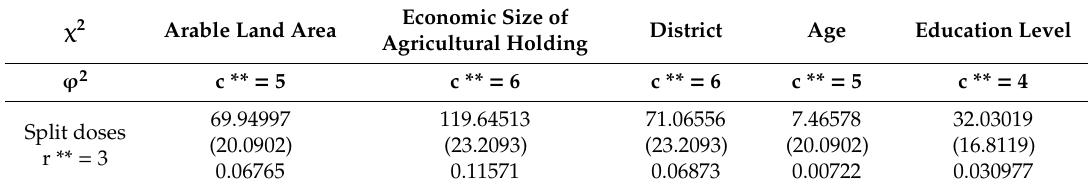
Table 5. Statistics values χ 2 , critical values χ 2 α = 0.01 * (in parentheses) and mean square contingency ϕ 2 for the following features: split doses of nitrogen fertilizers, arable land area, economics size of agriculture holding, and